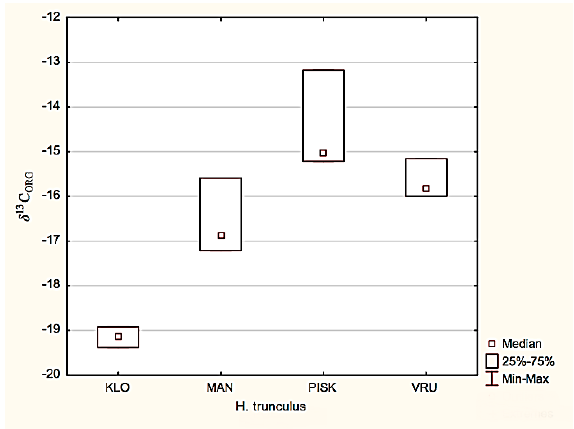
Figure 6. Box-plot diagram of the δ 13 C values of H. trunculus.